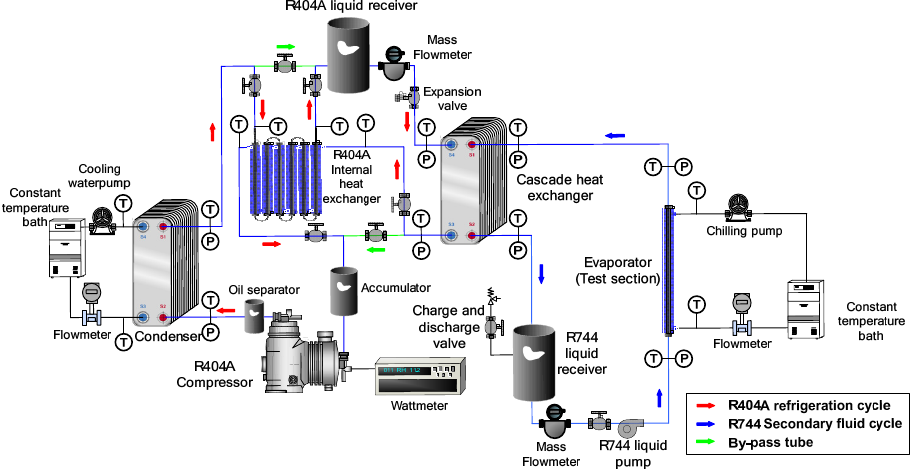
Figure 1. Schematic diagram of experimental apparatus for an IRS using R744 as a secondary fluid.